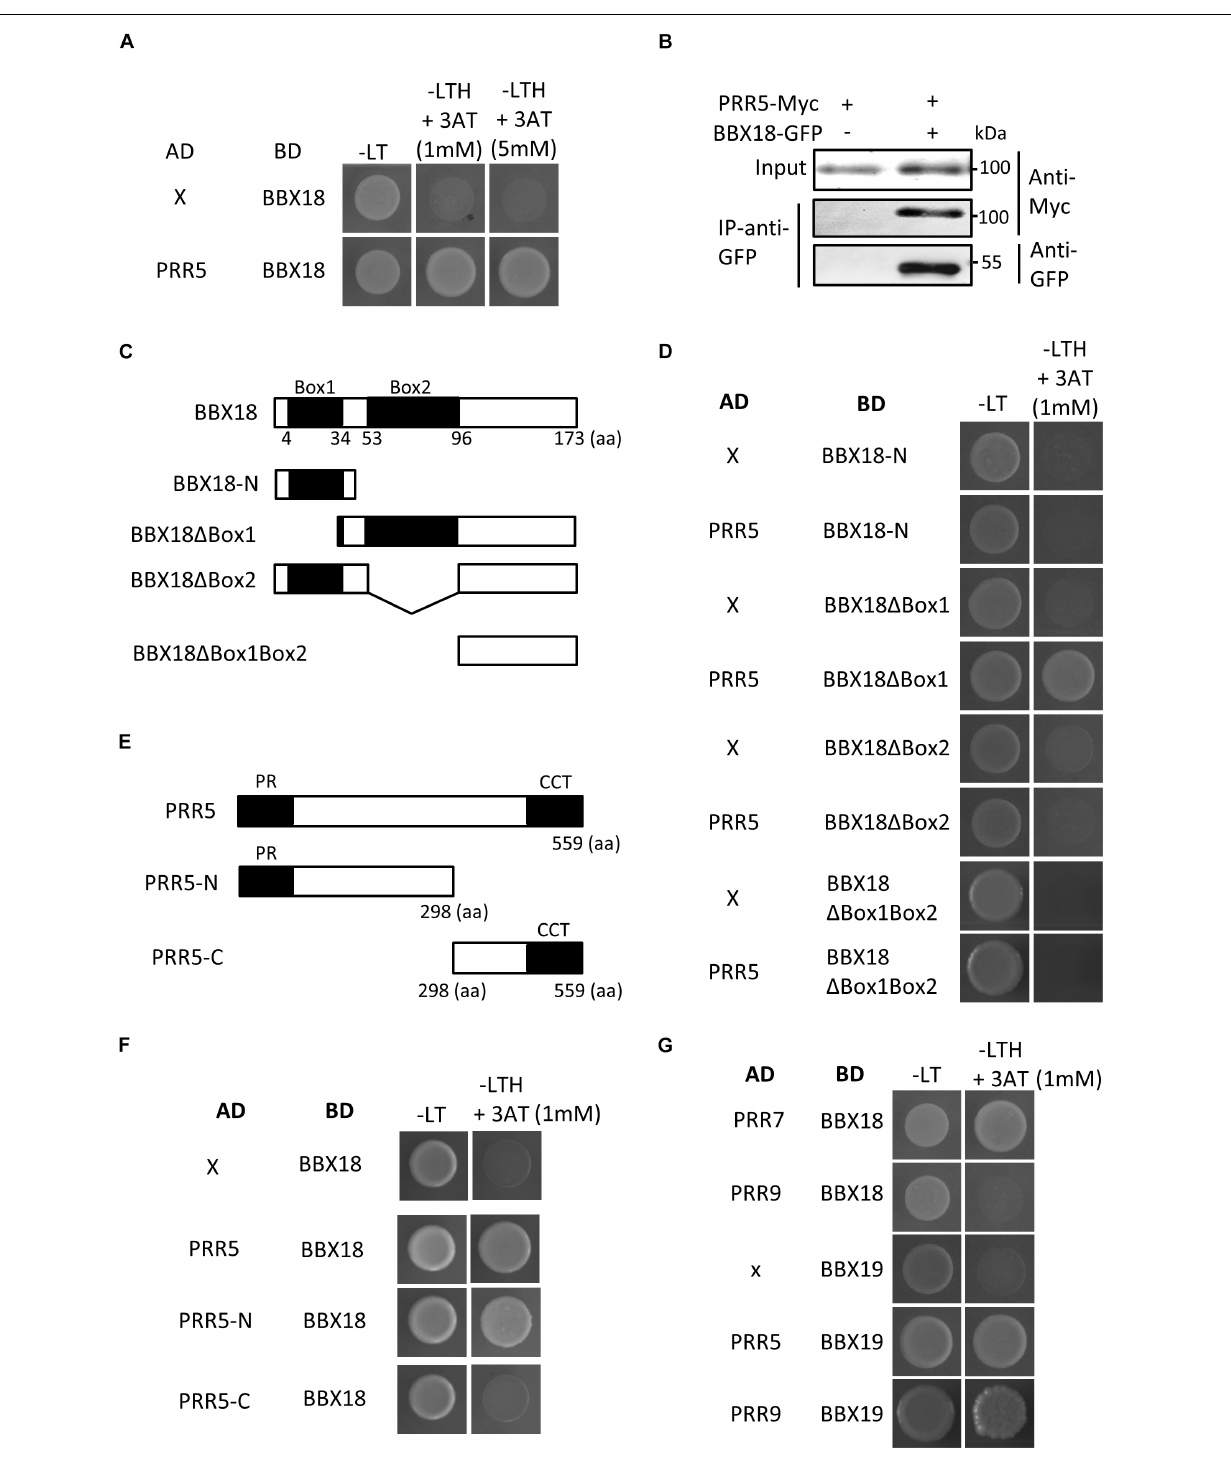
Frontiers in Plant Science |